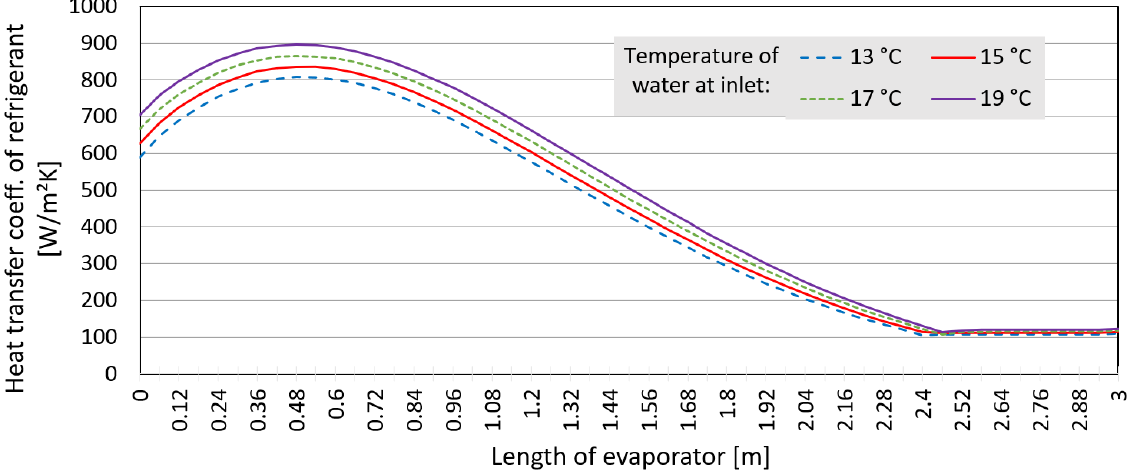
Figure 8. Variation of the heat transfer coefficient of the refrigerant.